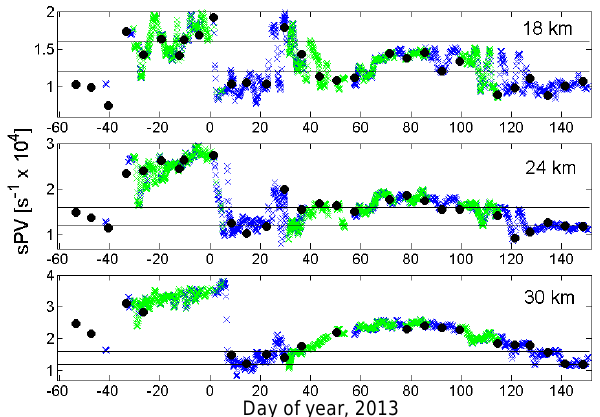
Figure 6. The sPV value corresponding to the measurement lo- cations of KIMRA (blue X), MIRA 2 (green X), and Sodankylä ozonesondes (black dot), at altitudes of 18, 24, and 30km. Lines of sPV values of 1.2 and 1.6 × 10 − 4 s − 1 , respectively defining the outer and inner edge of the polar vortex, are also